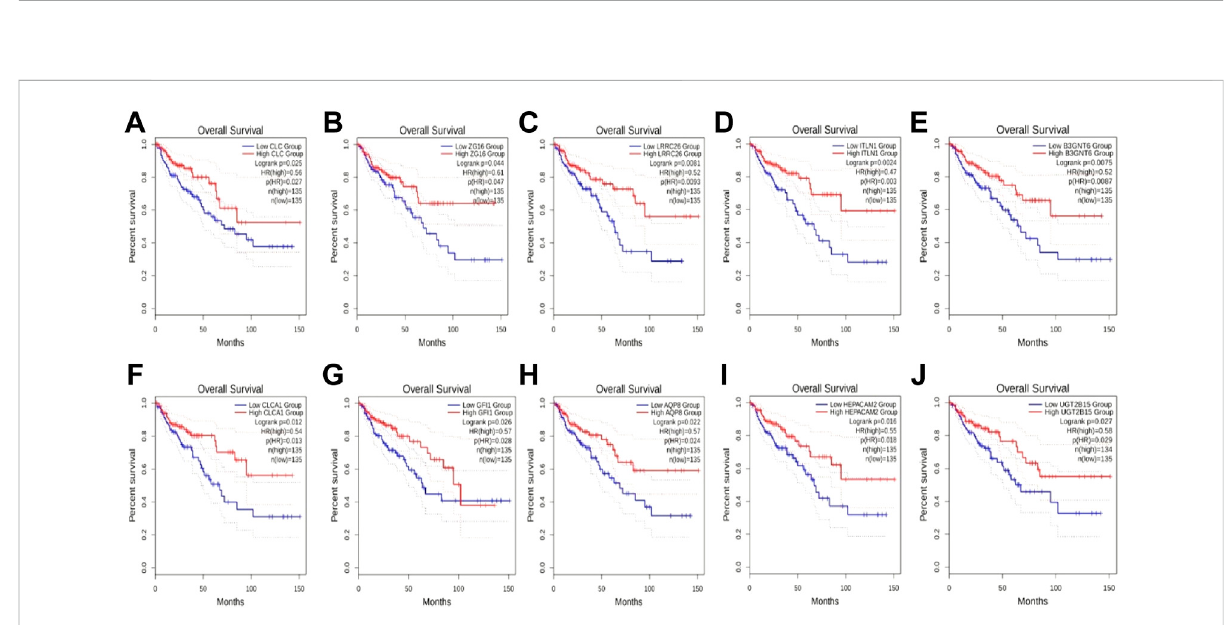
FIGURE 3 Theeffect ofDEGson survival time. (A) CLC, (B) ZG16, (C) LRRC26, (D) ITLN1, (E) B3GNT6, (F) CLCA1, (G) GFI1, (H) AQP8, (I) HEPACAM2, and (J)